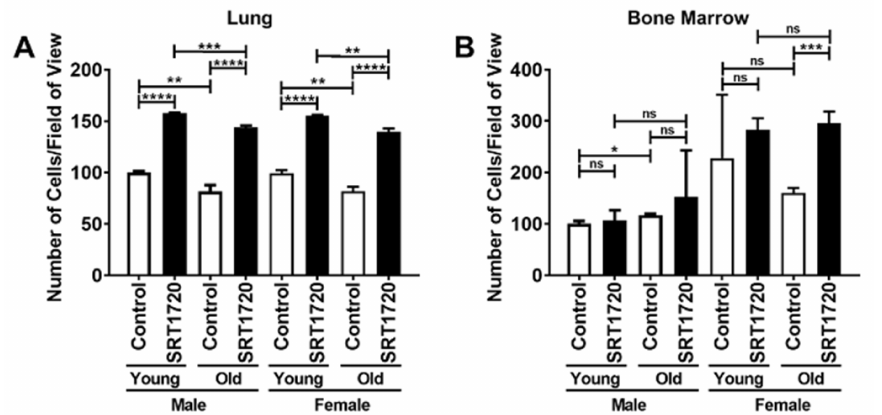
Figure 1. Proliferation of Endothelial Cells (ECs) isolated from the lungs ( A ) or bone marrow ( B ). Data are expressed as the mean ± SD. Young male control parameters were set to 100.0 and parameters in all other samples are shown relative to young male control. n = 4 mice/sex/age. ns = not significant, * p < 0.05, ** p < 0.01, *** p < 0.001, and **** p <